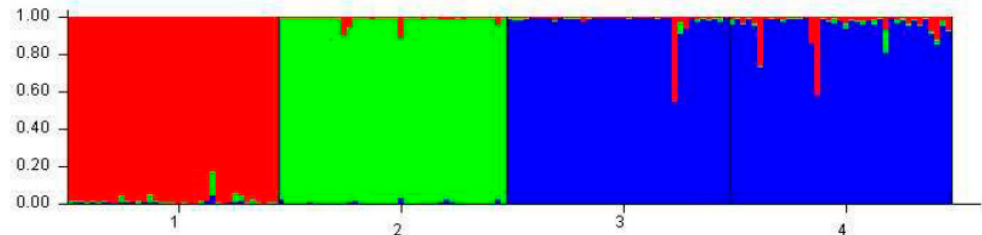
Figure 5. Individual grouping of 40 individuals from the four bovine breeds inferred by the Bayesian statistical method using the STRUCTURE program. Each of the 160 animals is represented by a vertical line divided into segments ranked according to color and size corresponding to the relative proportion of the genome of the animal corresponding to a particular cluster. Different breeds are separated by black lines. * 1 = Caracu; 2 = Nelore; 3 = Curraleiro and 4 = Bovino Pantaneiro .